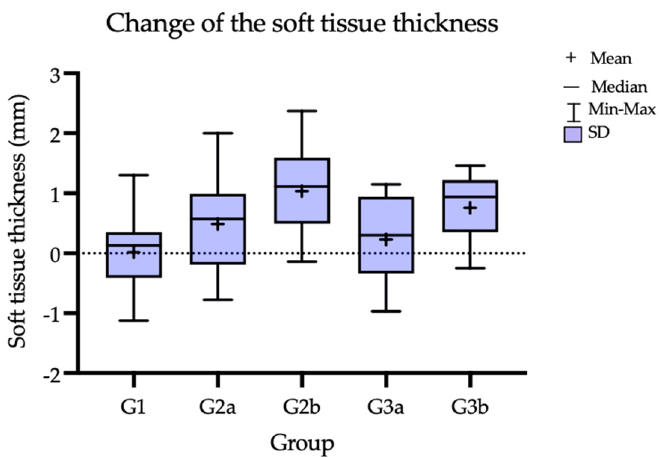
Figure 7. Change of the keratinized soft-tissue thickness (before treatment and at 5 years).